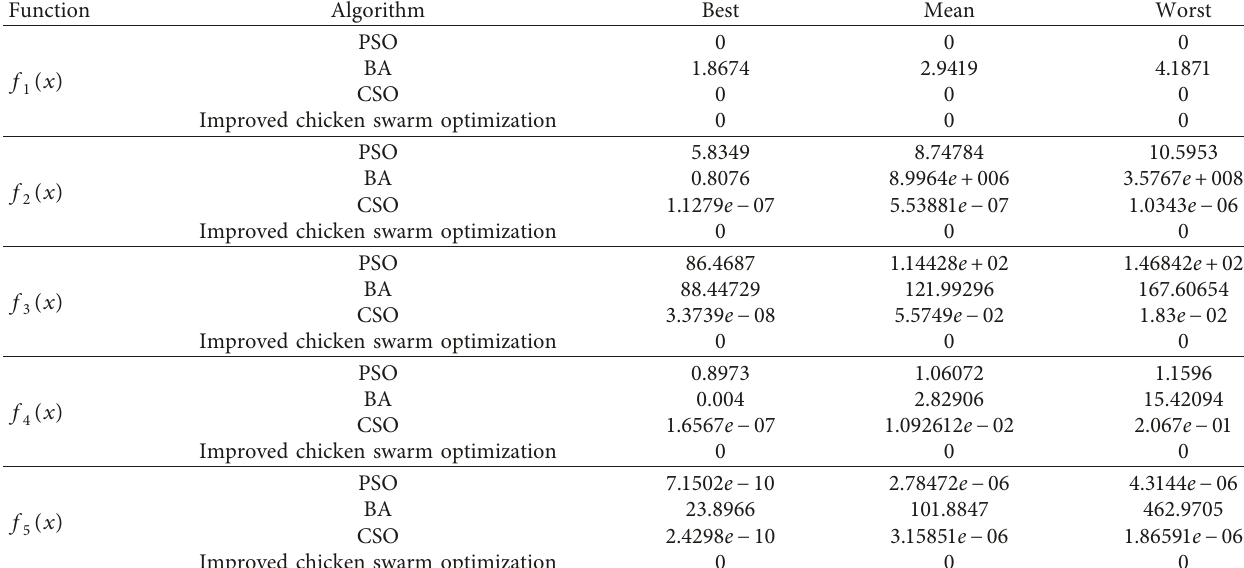
Table 3: Optimal calculation